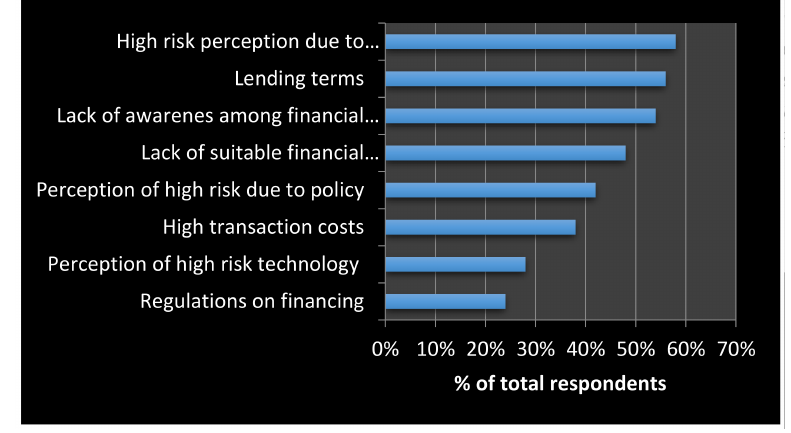
Figure 3. Perception about the financial challenge. Source: [44].